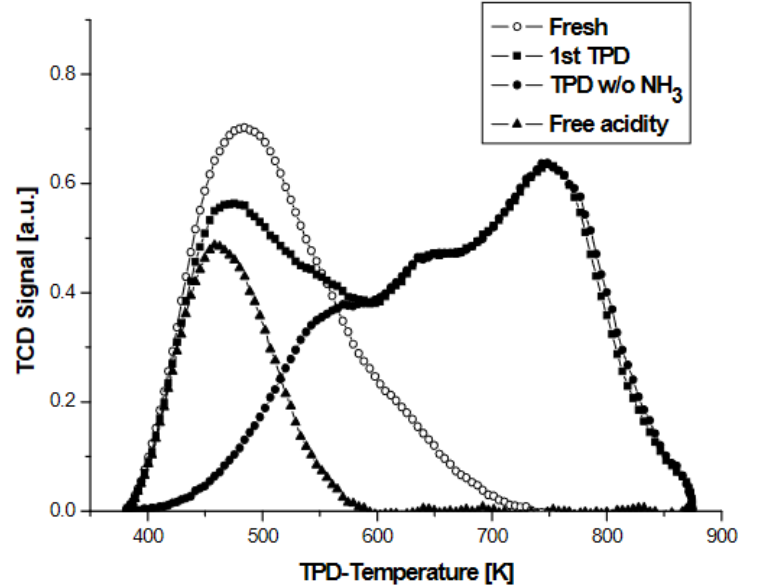
Figure 19. Determination of free acidity of deactivated USHY zeolite via TPD experiments (using NH 3 as probe molecule). Wang et al. [181].